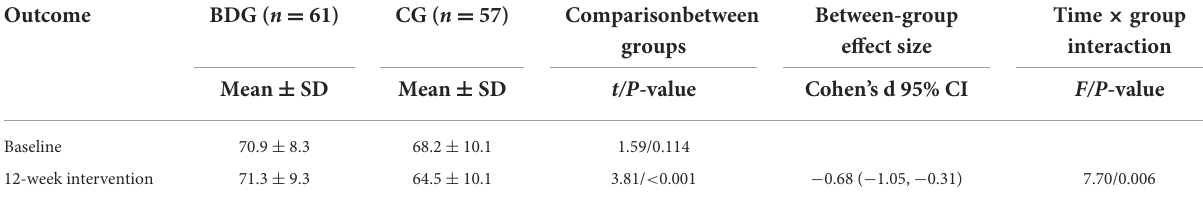
TABLE 3 The comparison of the composite scores of health-related physical fitness between the two groups (percentile system). Outcome BDG ( n = 61) CG ( n = 57) Comparisonbetween